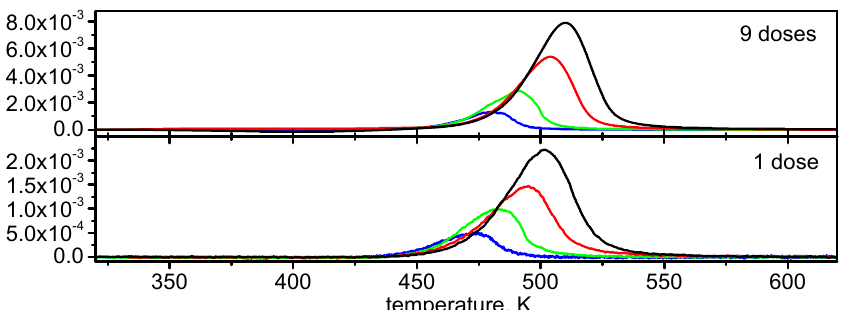
Figure 4. MFI–30 TPSR profiles after 1 and 9 loop doses of ethanol measured at different heating rates (black curves—15 K · min − 1 ; red curves—10 K · min − 1 ; green curves—5 K · min − 1 ; blue curves—2.5 K · min − 1 ). The y-axis is the rate of formation of ethylene in µ mol · s − 1 .